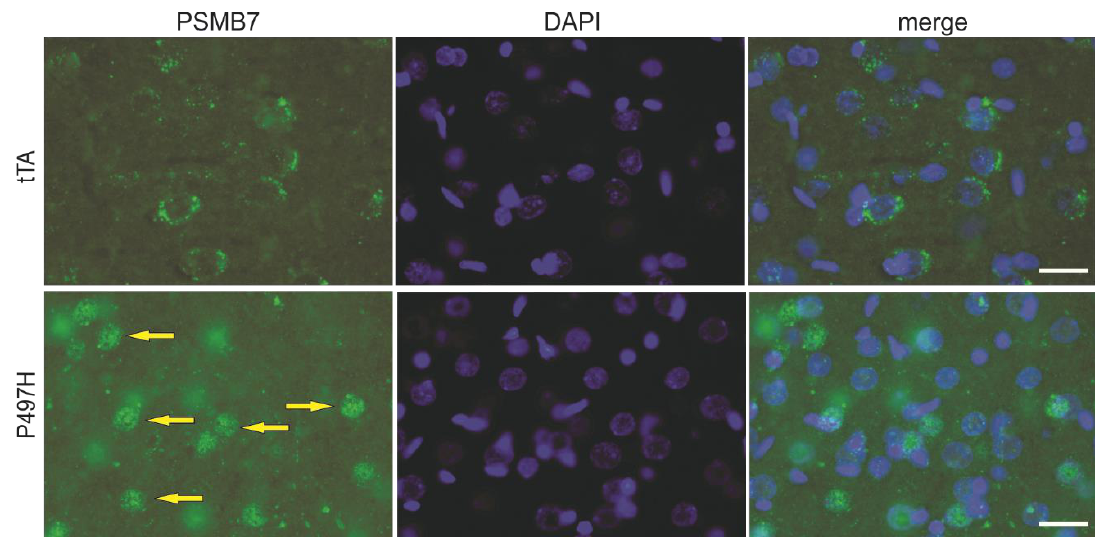
Figure 4. Proteasome subunit PSMB7 localization in mutant UBQLN2 rats. Immunofluorescence staining showed that PSMB7 was mislocalized to nuclei in the frontal cortex sections from 40-week-old mutant UBQLN2 rats (yellow arrows). Scale bars 30 μm.